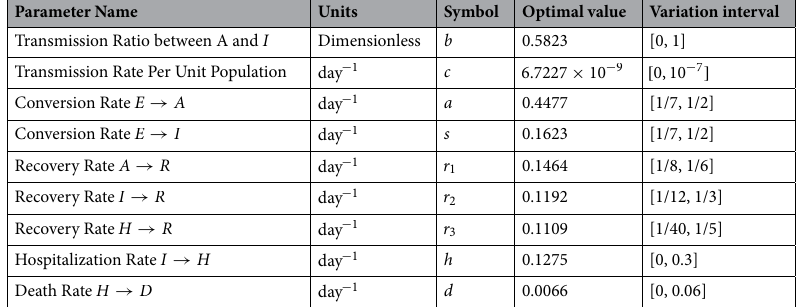
Table 1. Optimized model parameters for the single population model, and the variation interval of each parameter within the optimization process (for further details, see “Methods” section).